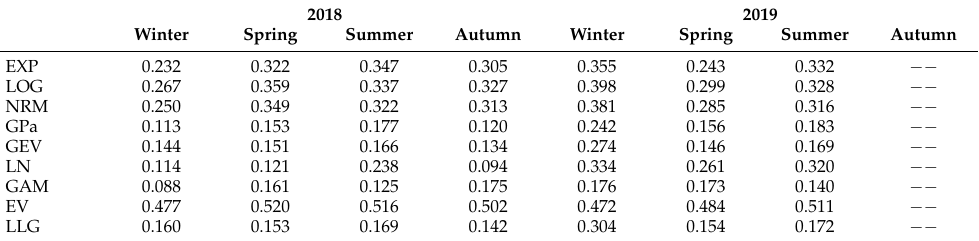
Table 15. KS-test results for the L-moment estimation, for the 50 m